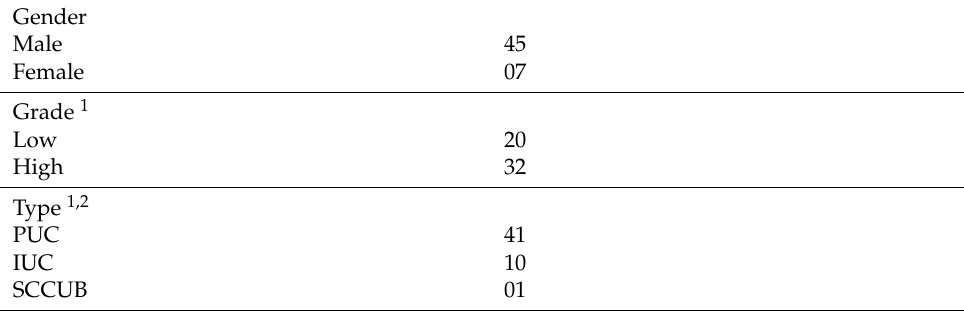
Table 1. Study population